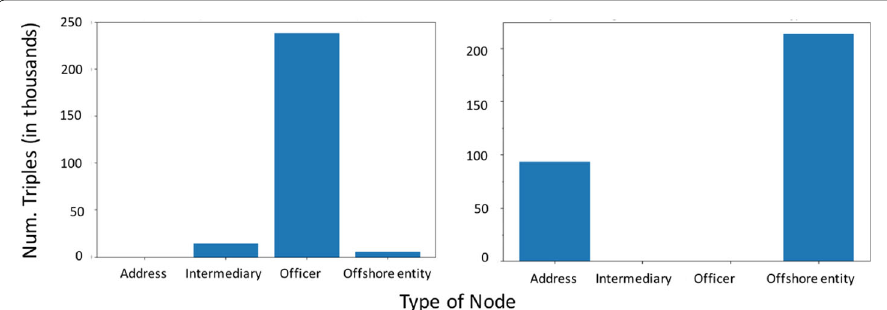
Fig. 4 Number of triples (each triple being of the form (start-id, relation, end-id)) where a node of the type shown on the x-axis occurs as the start-id node (left) and end-id node